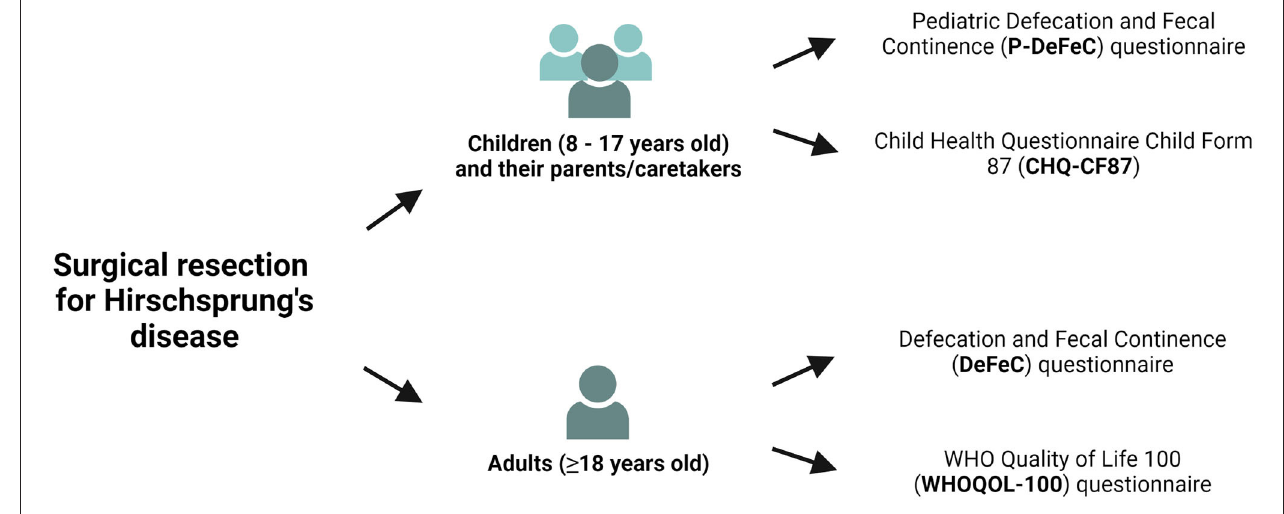
FIGURE 1 | Flowchart of the study design.